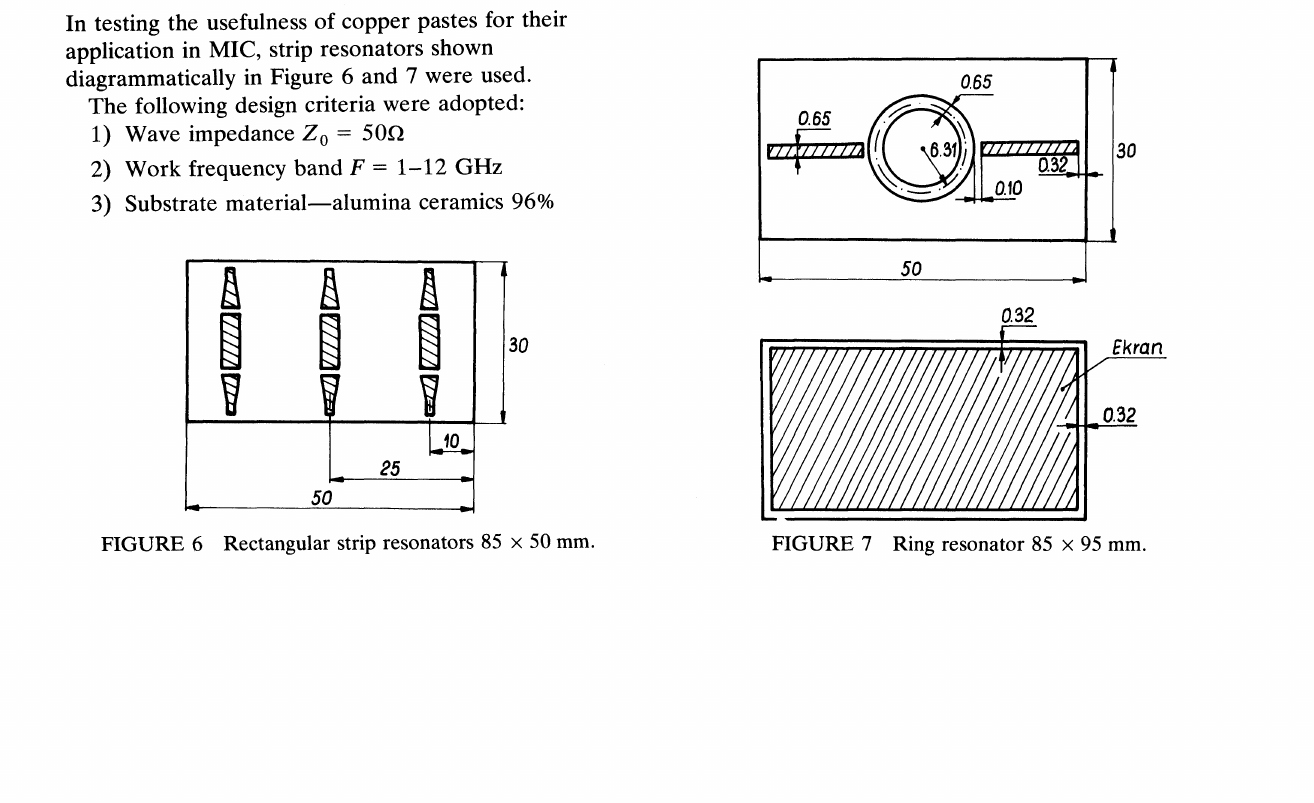
FIGURE 6 Rectangular strip resonators 85 x 50 mm. FIGURE 7 Ring resonator 85 x 95